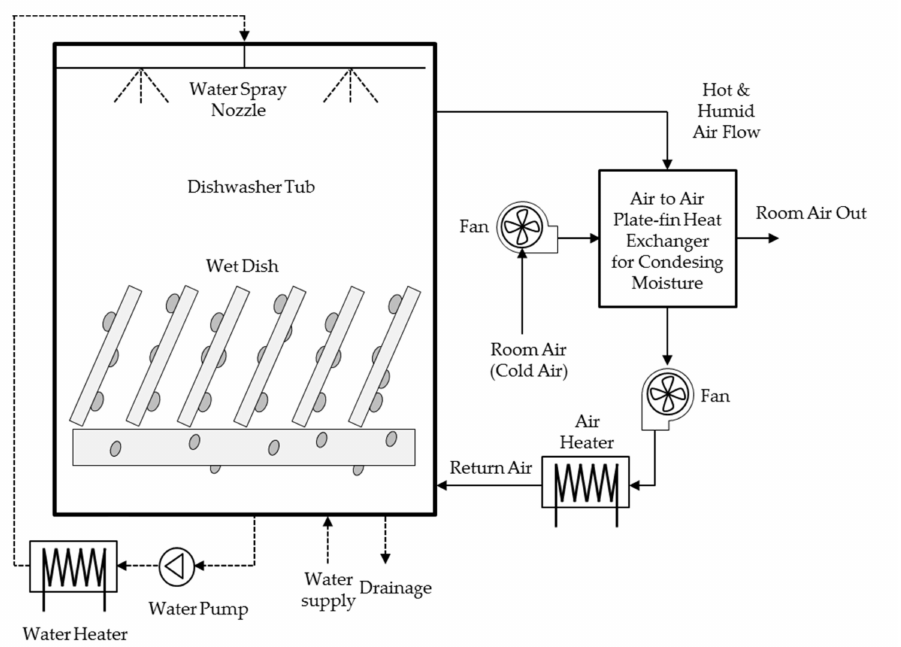
Figure 1. Schematic diagram of the plate-fin heat exchanger for condensing the moisture from the humid hot air in the household dishwasher used in this study.